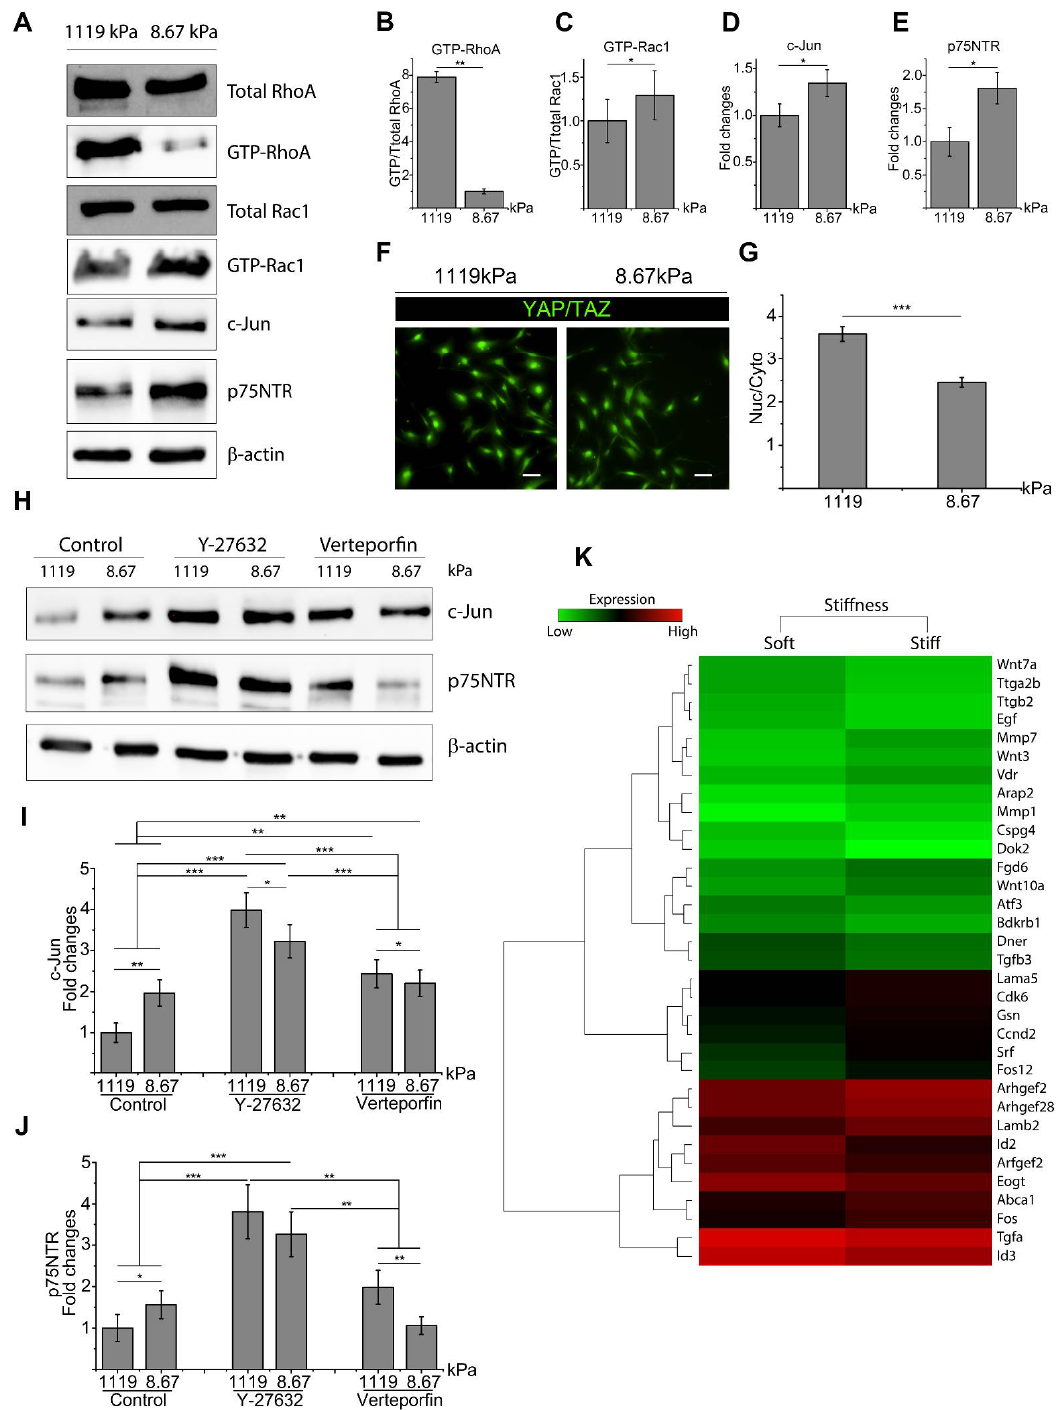
Figure 1. Increases in extracellular matrix (ECM) stiffness promoted RhoA and YAP/TAZ activity, which led to decreased expression of regenerative markers. ( A – E ) Western blot shows that the expression of key factors can be regulated by ECM stiffness in Schwann cells (SCs). Four unique cell lysates were created for Western blots. ( F , G ) Nuclear YAP/TAZ (green) is upregulated as ECM stiffness increases. A total of 98 cells were quantified per well, with 6 wells quantified in each of 2 unique trials. Scale bar = 50 µ m. ( H – J ) Expression of c-Jun and p75NTR are enhanced by RhoA and YAP/TAZ inhibition, with RhoA inhibition resulting in higher expression compared to YAP/TAZ inhibition. Three lysates for c-Jun and two lysates for p75NTR were created for Western blots. ( K ) Heatmap generated by microarray analysis shows up- and downregulated genes that are associated with either mechanotransduction or SC regenerative phenotypes. Data are presented as the mean ± SEM. * p < 0.05, ** p < 0.005, *** p < 0.0005, p -values found in Supplemental Table